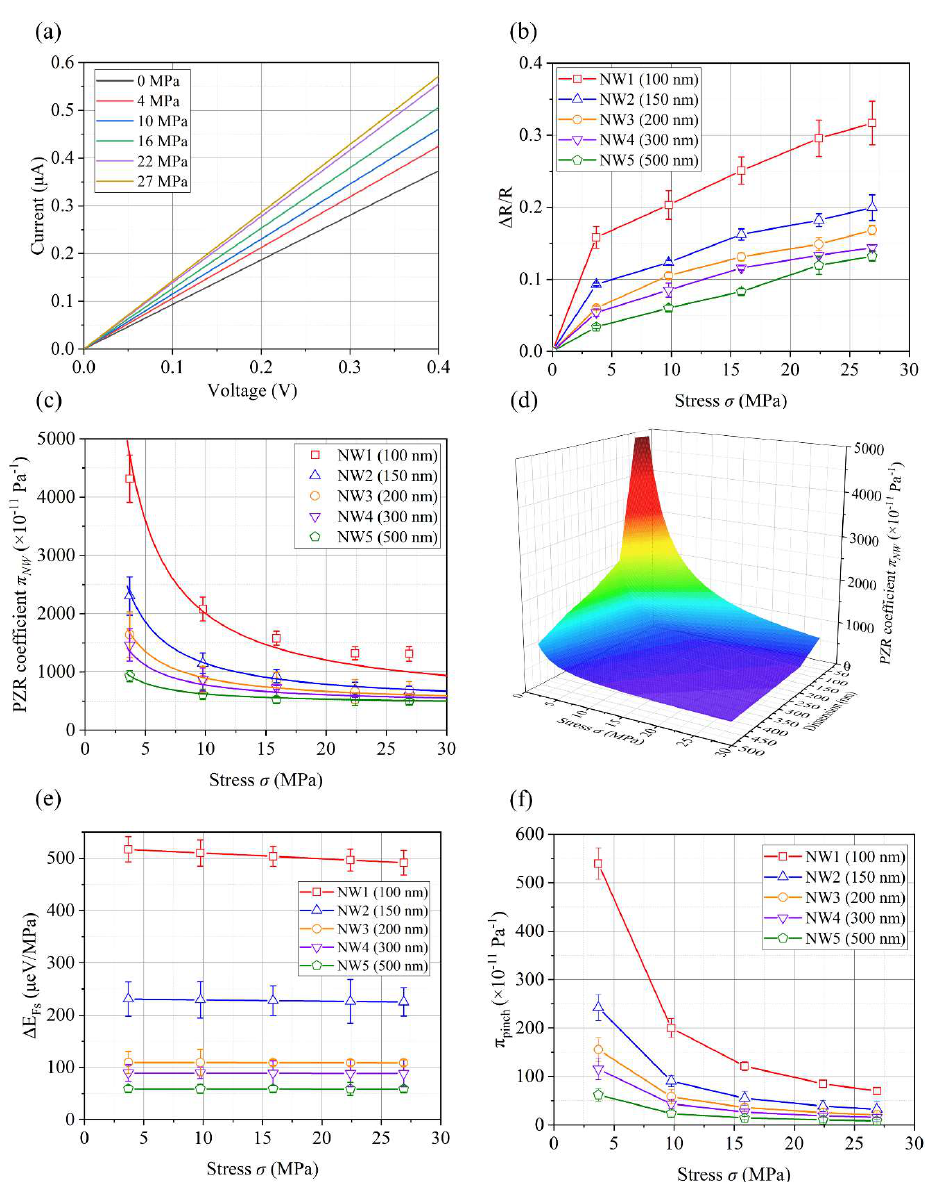
Figure 6. Analysis of the PZR effects for fabricated SiNWs. ( a ) The measured I-V characteristics of NW1; ( b ) the measured resistance variation of fabricated SiNWs with respect to the compressive stress; ( c ) comparisons between the measured PZR effects of fabricated SiNWs and the proposed PZR model. R-squared value of NW1 to 5 are 0.94, 0.99, 0.97, 0.95, and 0.98, respectively; ( d ) the proposed PZR model as a function of SiNW dimension and stress; ( e ) estimated surface Fermi energy of fabricated SiNWs based on the proposed PZR model; ( f ) estimated PZR coefficient induced by the piezopinch effects based on the proposed PZR model.